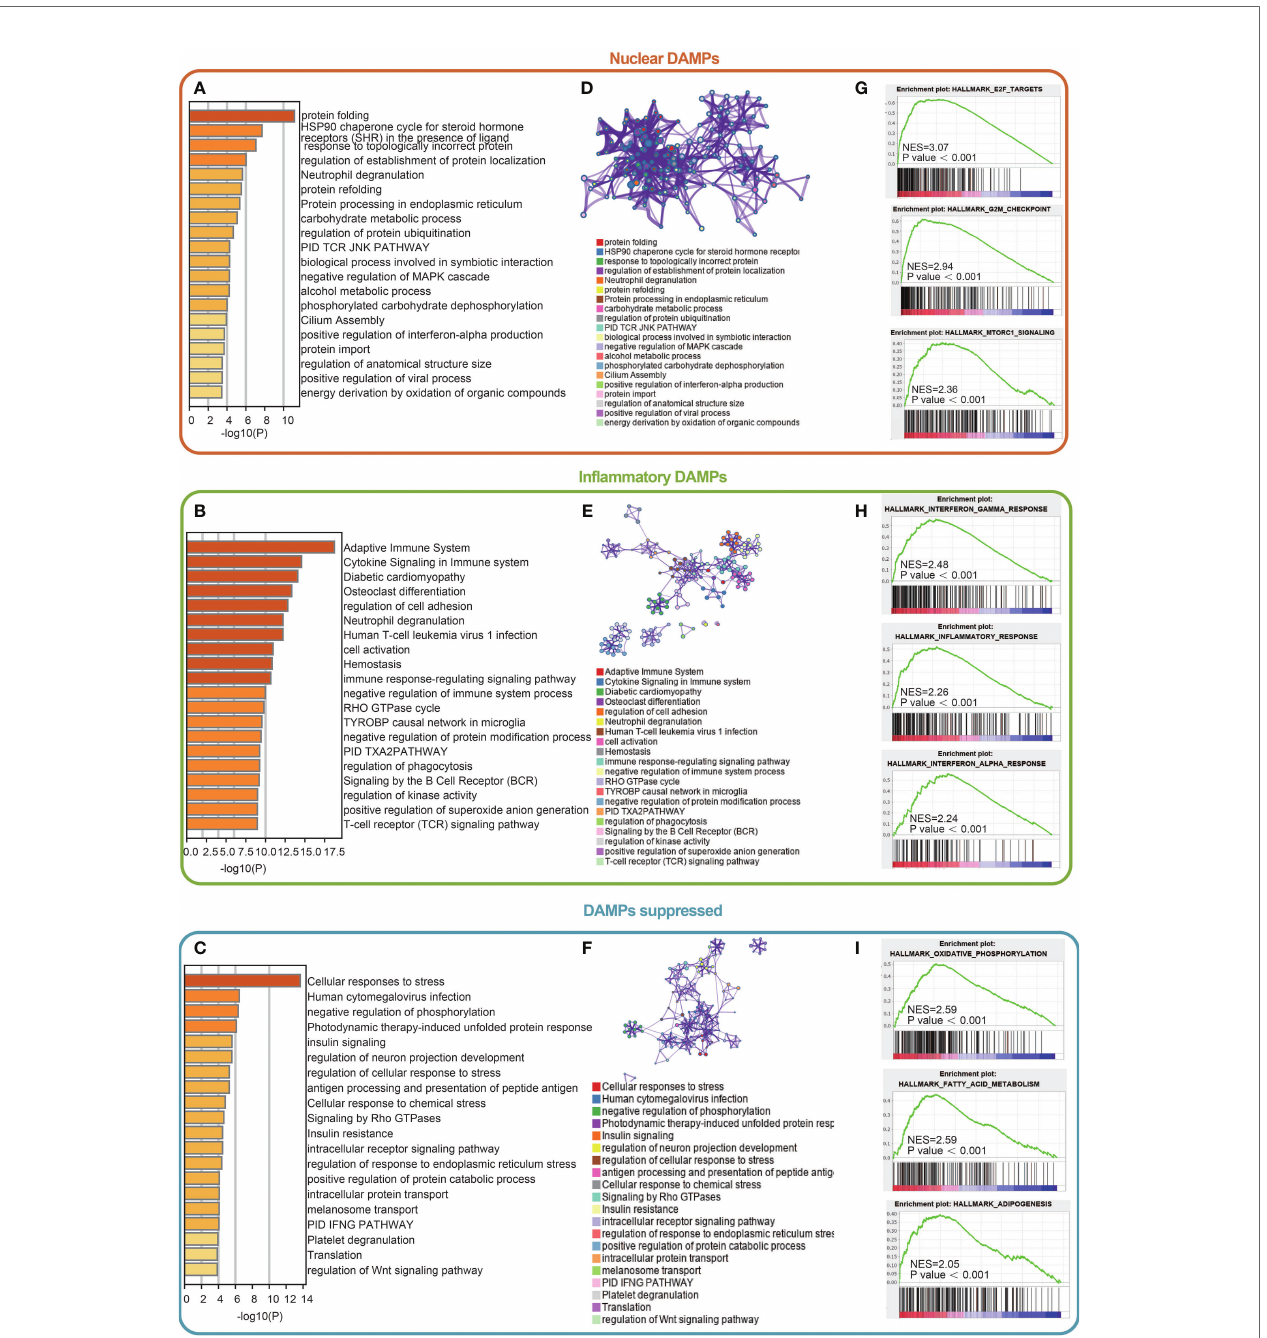
FIGURE 3 | Differentially expressed gene (DEG) analysis and functional analyses. (A-C) Bar diagram showing the signaling pathways enriched by Kyoto Encyclopedia of Genes and Genomes (KEGG) analysis. (D-F) Circle plot and network visualizing the biological processes enriched by gene ontology (GO) analysis. (G-I) Gene set enrichment analysis (GSEA) results showing the activated signaling pathways in the DAMPs-associated